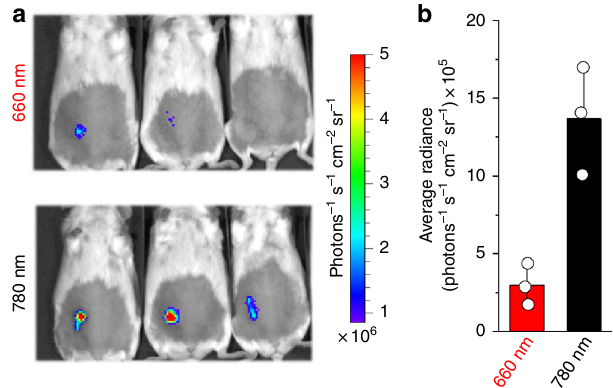
Fig. 9 Light-induced activation of MAPK/ERK pathway in mice. a PC6-3 cells were co-transfected with pCMVd2-Dr-TrkA, pFA-Elk-1, and pFR- RLuc8 plasmids and injected 25 h later in mammary glands of female mice. Mice were kept in transparent cages and illuminated from below with either 660/25 nm or 780/25nm LED arrays at 3 mW cm − 2 for 19 h. Then, animals were injected with a coelenterazine substrate for RLuc8 luciferase through retro-orbital vein and immediately imaged with an IVIS Spectrum instrument. b Quanti fi cation of the RLuc8 reporter signals shown in a . Error bars represent s.d., n = 3